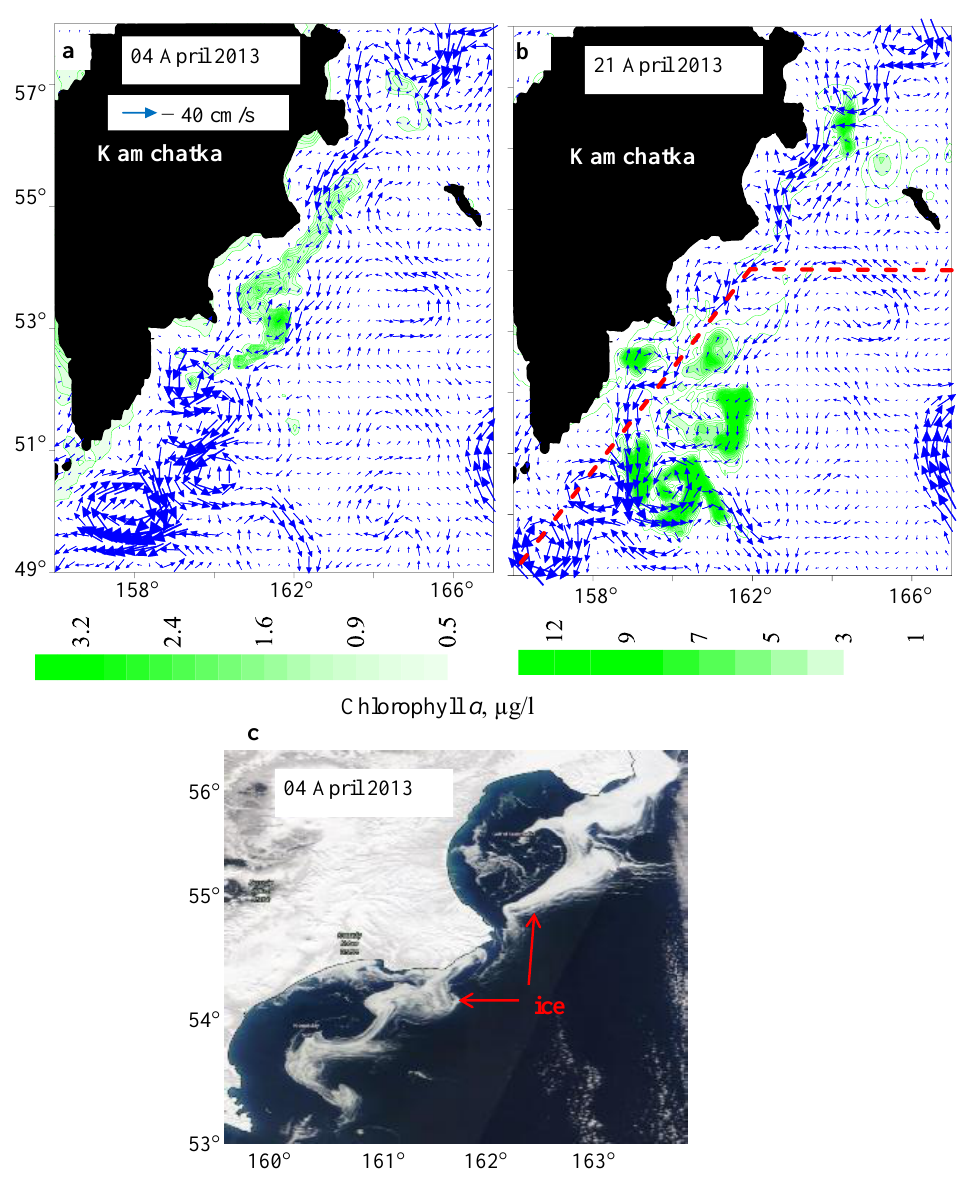
Figure 5. The surface current velocity maps and chlorophyll a concentration distribution (4 April and 21 April 2013) ( a , b ) and satellite image of the eastern Kamchatka region ( c ). For the western part of the subarctic North Pacific, the change in the carbonate pa- rameters in the surface waters caused by the formation of carbonates is insignificant [29]. During the synthesis of organic matter, CO 2 and nitrate are consumed, which is accompa- nied by a decrease in DIC and an increase in TA [30]. The changes in DIC, TA, and pCO 2 during photosynthesis could be quantified using the Redfield ratio (C:N:P = 117:16:1) [31] and CO2SYS Program [25]. For the eastern Kamchatka area, a decrease in DIC concentra- tion by 50 µmol l −1 and an increase in TA by 7 µmol l −1 during the phytoplankton bloom in early spring (t = 0 °C, S = 33.0, DIC = 2126 µmol l −1 , TA = 2240 µmol l −1 ) lead to a decrease in pCO 2 by 120 µatm (from 390 to 270 µatm). Therefore, to reduce pCO 2 from 390 to 270 µatm in the EKC zone in April 2013, the DIC concentration had to decrease by 50 µmol l −1 .